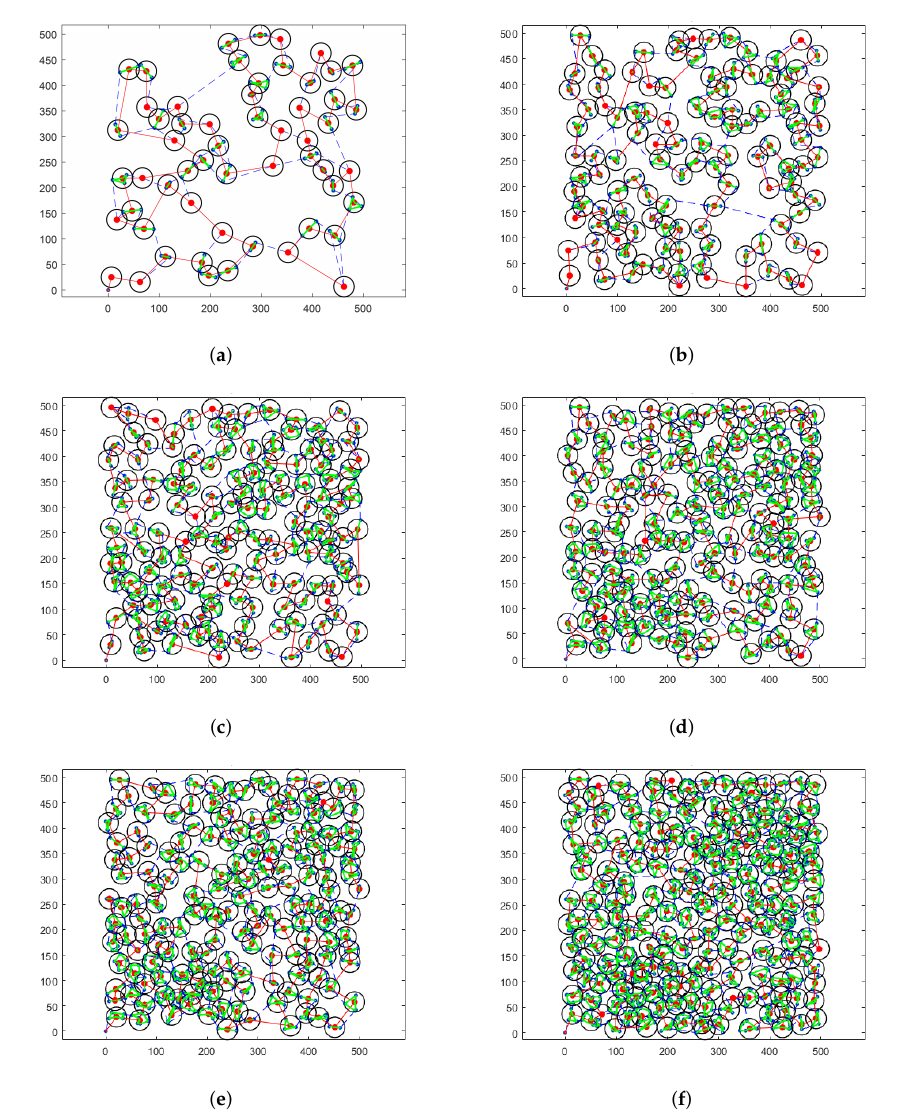
Figure 6. Scheduling results of TSPA and SA-TC. ( a ) 100 targets, ( b ) 300 targets, ( c ) 500 targets, ( d ) 700 targets, ( e ) 900 targets, ( f ) 1200